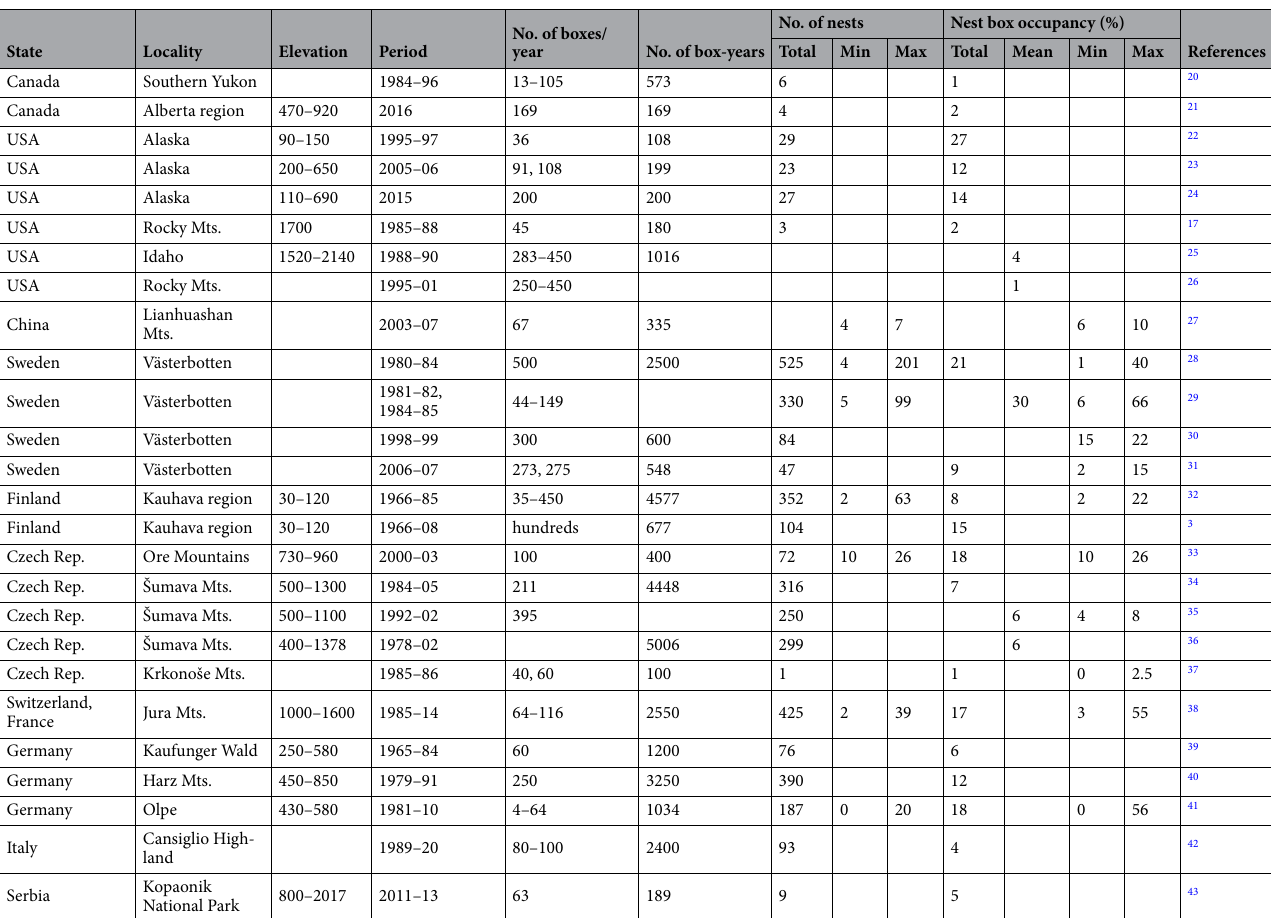
Table 1. Nest box use by the boreal owl in Europe, North America, and Asia; the state, locality, elevation, period, the number of boxes, nests, box-years, and the nest box occupancy (expressed as the proportion of occupied nest boxes of checked boxes). The way how authors described their results varied hugely. Therefore, we present the information on the number of boxes, nests, and nest box occupancy from long-term